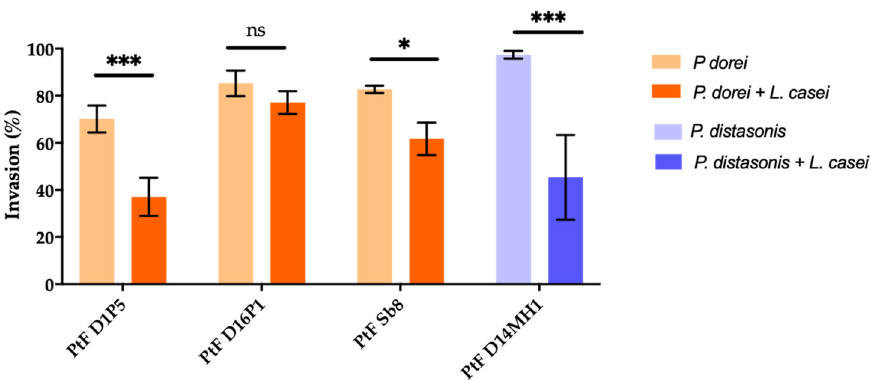
Figure 4. Effect of the presence of Lactobacillus casei DSM 20011 on the invasion ability (%) of P. dorei strains ( P. dorei + L. casei ) and P. distasonis ( P. distasonis + L. casei ). * p < 0.05; *** p < 0.001, ns—not significant.